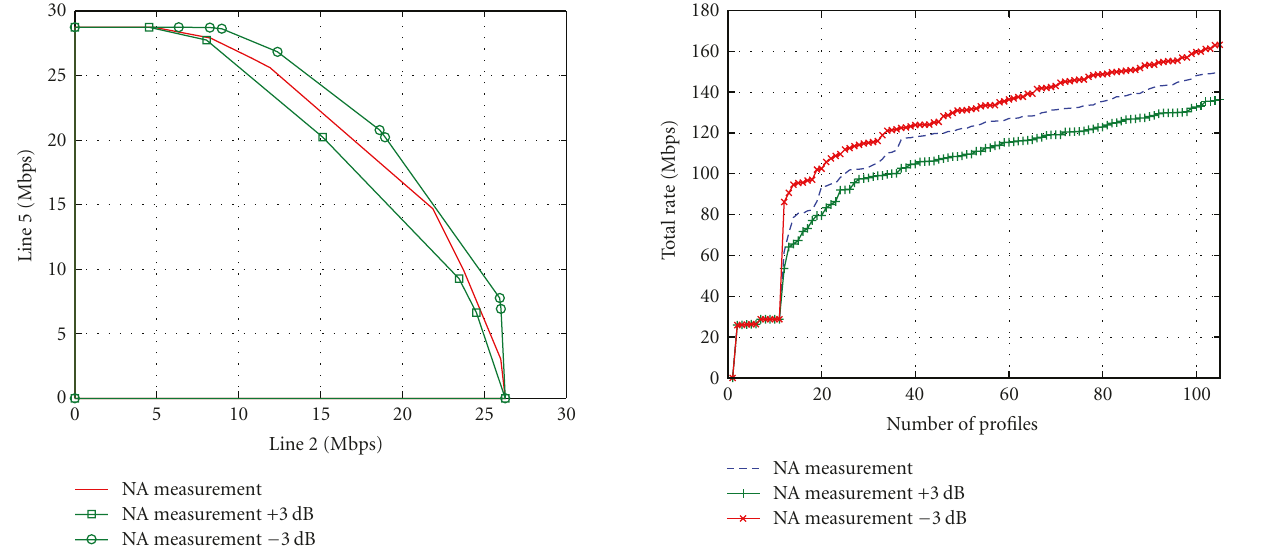
Figure 12: Section of the 10-dimensional rate region curve, obtained with SCALE, for 2 users (out of 10 users) with equal length lines (2200m).